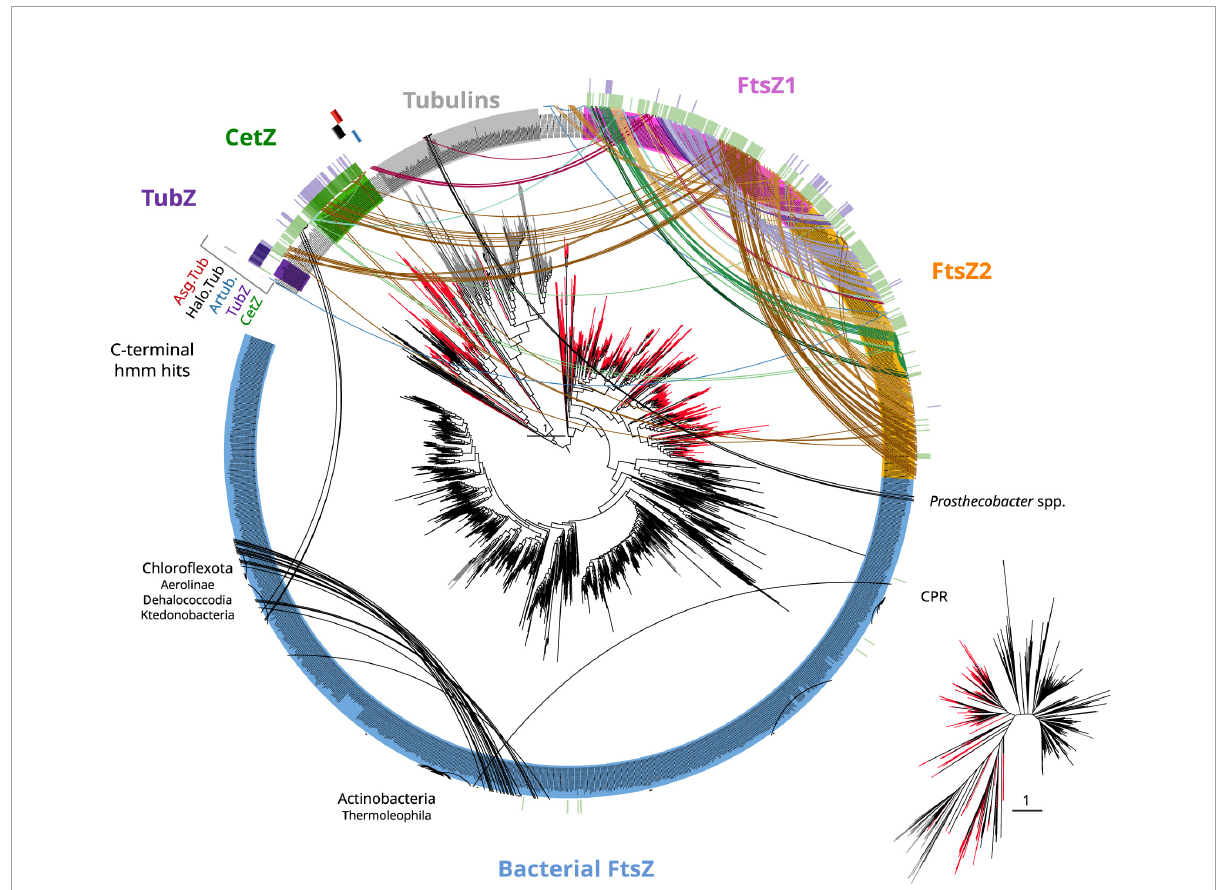
FIGURE5 Tubulin/FtsZ-like paralogs in archaea and C-termini domain homologies. The phylogeny of Figure 4 was used to map the hits of HMMSEARCH of the C-termini of different phylogenetic groups (external colored heatmaps): CetZ, TubZ, artubulins, Halo.Tub, and Asg.Tub, showing the relationship between CetZ and archaeal FtsZ, as well as the overlap between CetZ and TubZ. Branches are colored by domain: black bacteria, red archaea, and gray eukaryota. Arcs connect sequences from the same organism showing the abundance and taxonomic diversity of FtsZ paralogs in archaea. Arc colors follow the legend of Figure 4 . Inset represents an unrooted tree of the same phylogeny. Refer to the extended tree for annotations in Supplementary Figure 4